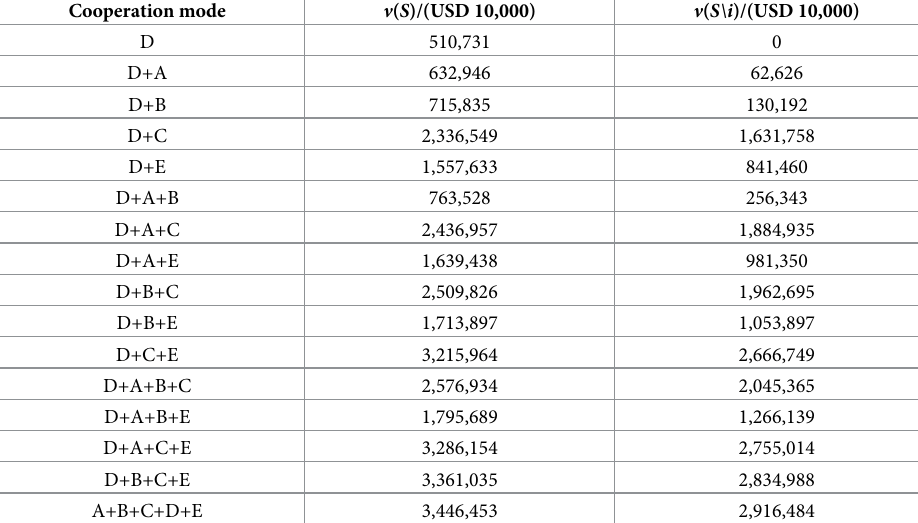
Table 10. Profits of 16 cooperation modes between Cambodia and other four